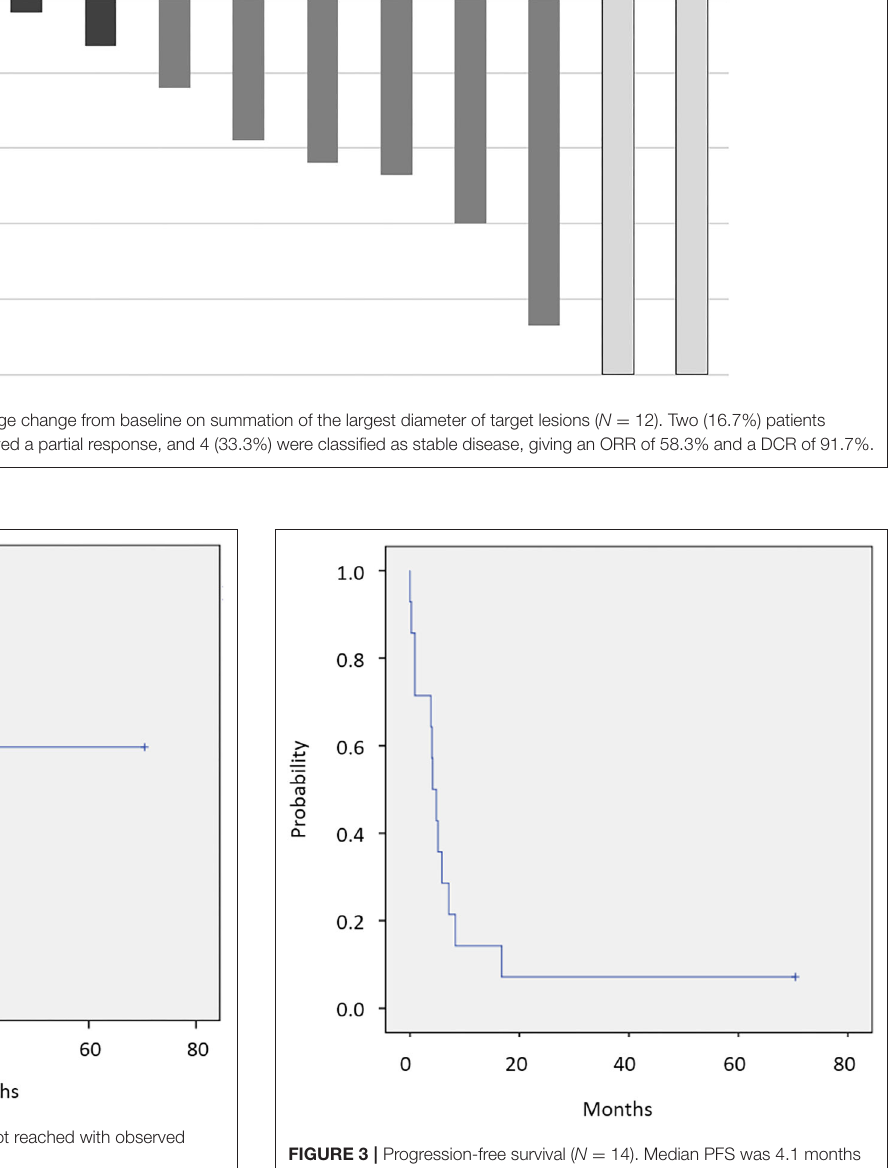
(2). On the other hand, GEM is not covered by insurance in some countries, including Japan; in these countries, an EGFR inhibitor- containing regimen is sometimes used as first-line treatment for R/M NPC. CDDP + 5FU + Cmab (EXTREME regimen) is